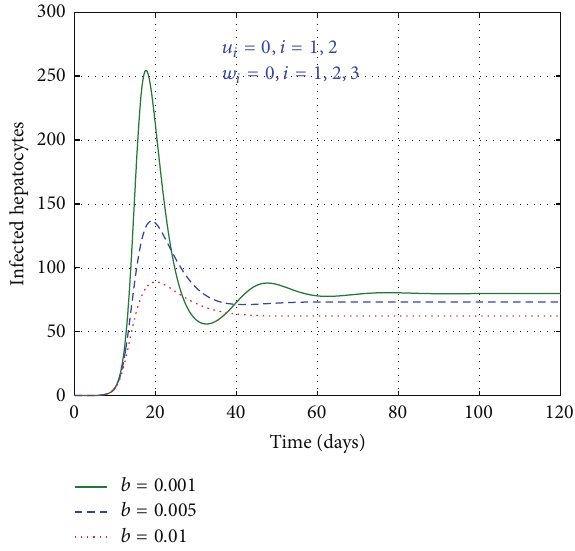
Figure 2: The evolution of infected hepatocytes for untreated